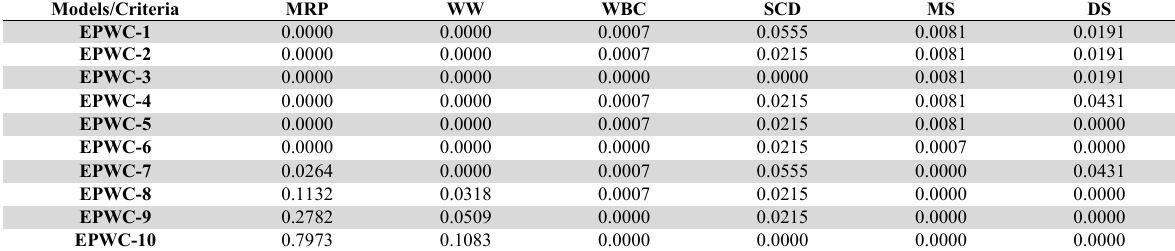
Weighted NDA for EPWC selection Models/Criteria